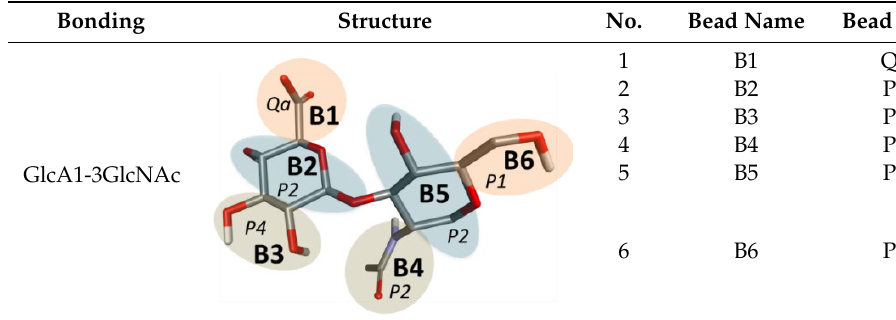
Table 1. Assignment of Martini CG bead types for the HA1-3 disaccharide.